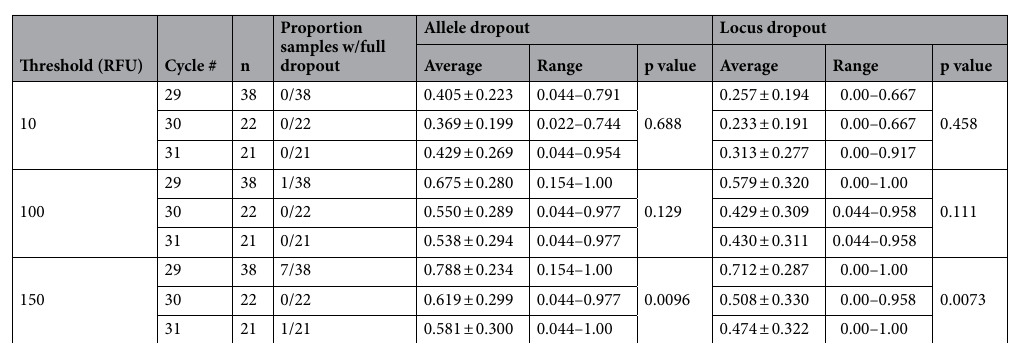
Table 2. Summary of the mean cycle set allele and locus dropout, the range (minimum-to maximum values observed separated by cycle number and the analytical threshold value used to assess the signal) and the p values of the ANOVA comparing the variance at each threshold across cycle numbers at α =